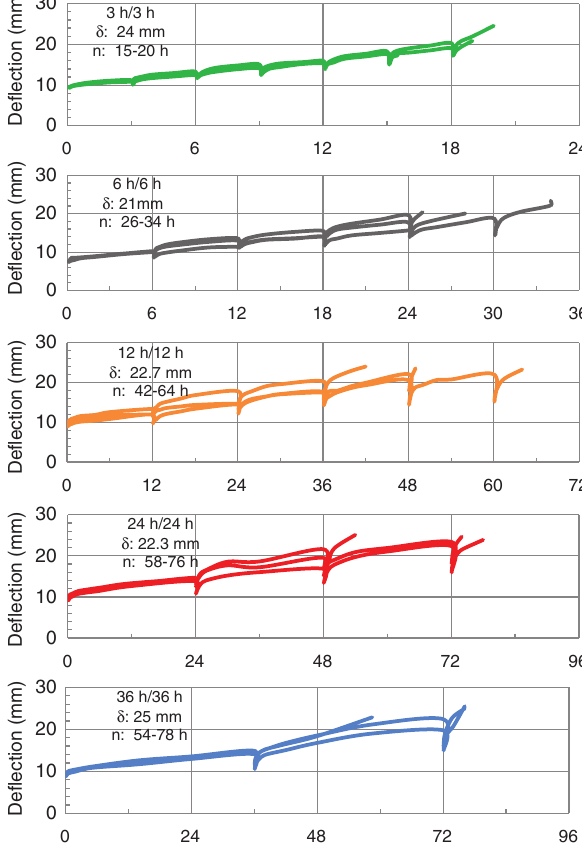
Figure 5: R = -1 creep test results. Average deflection to failure similar in all cases at ~ 23